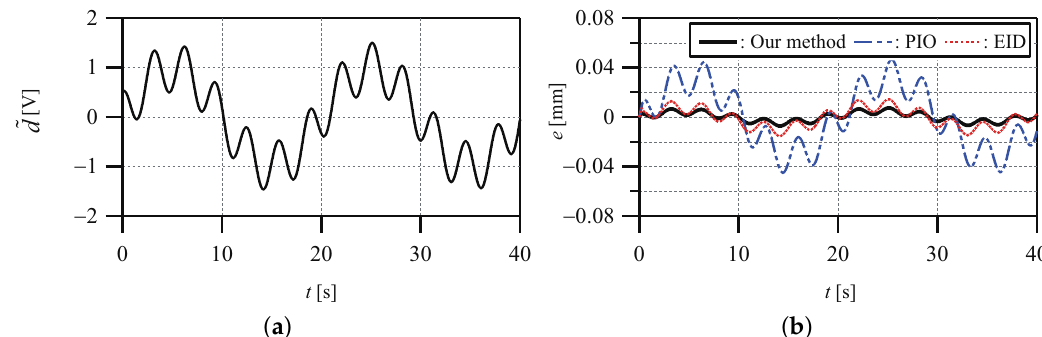
Figure 9. Comparison of IEID and PIO and the conventional EID method for the magnetic levitation ball system. ( a ) Exoge- nous disturbance; ( b ) Outputs of IEID, PIO, and conventional EID